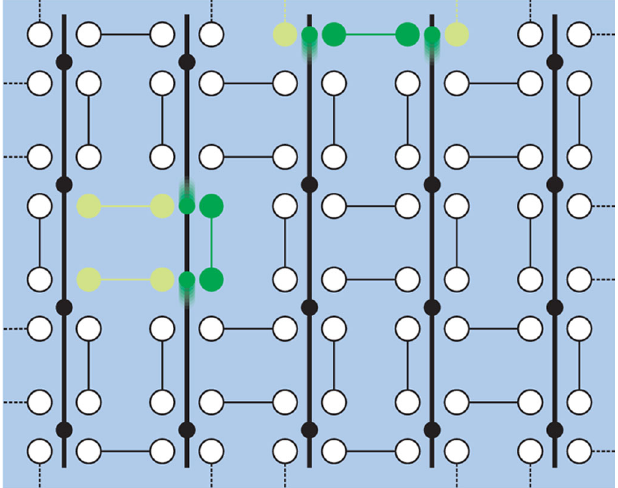
FIG. 5. Architecture based on nanowire QDs coupled by me- tallic gates. The spin qubits are confined to QDs (black dots) on nanowires. The nanowires form a parallel array (vertical black lines). The coupling between neighboring spin qubits is enabled by floating metal gates (white circles) positioned either parallel to the wires (and thus coupling QDs created in the same wire), or perpendicular to the wires (and thus coupling QDs created in adjacent nanowires). By using external gates (not shown) to move the dots along the nanowires (shaded green colors on the wires), it is then possible to selectively couple one particular QD to only two surrounding gates (green and yellow ‘‘active’’ gates). The other QD partner also couples to one of these active gates (green), resulting in a selective coupling of the desired nearest- neighbor